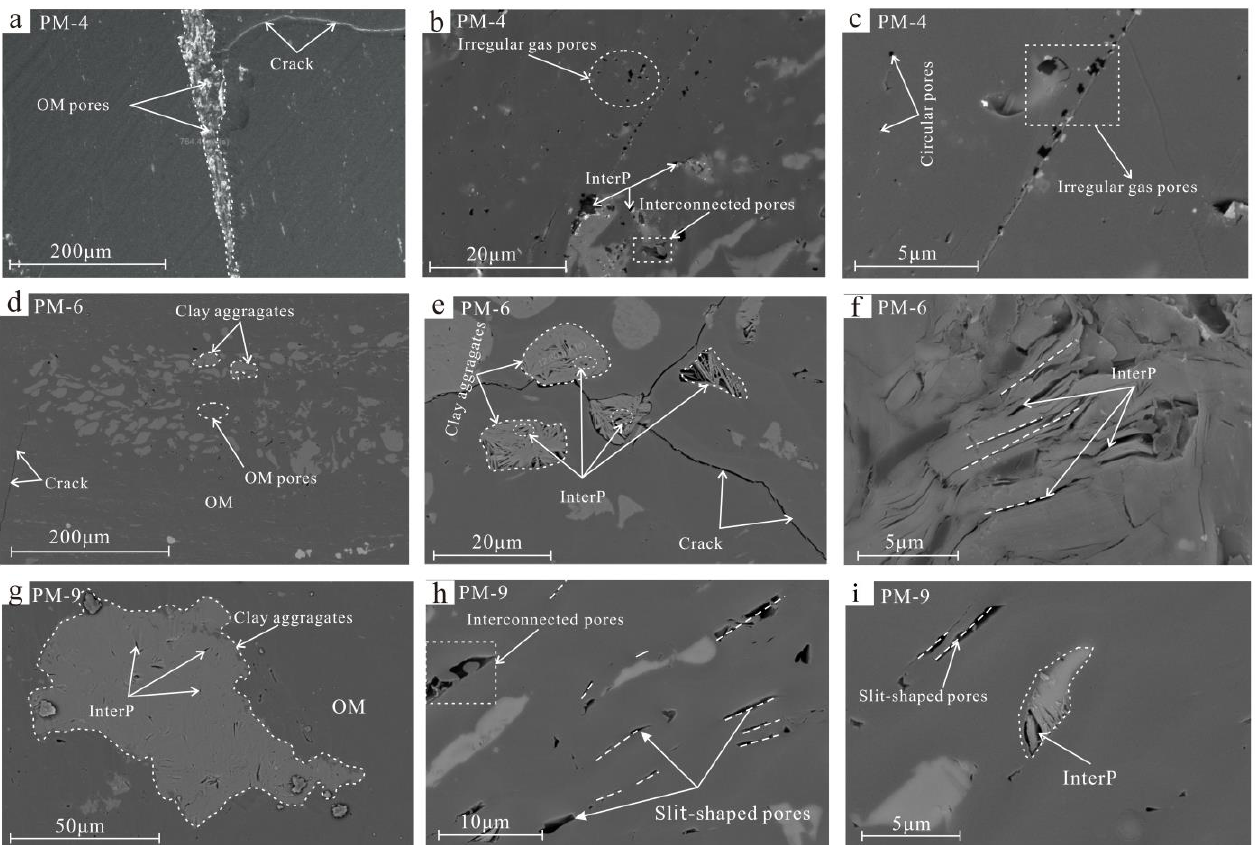
Figure 2. FE — SEM images of the organic and inorganic pores in selected coal samples. ( a – c ) The pore – fracture distribution and irregular gas pores, sample PM-4. ( d – f ) The coal matrix and clay mineral distribution and InterP pores, sample PM-6. ( g – i ) Directional alignment and some slit-shaped pores, sample PM-9.